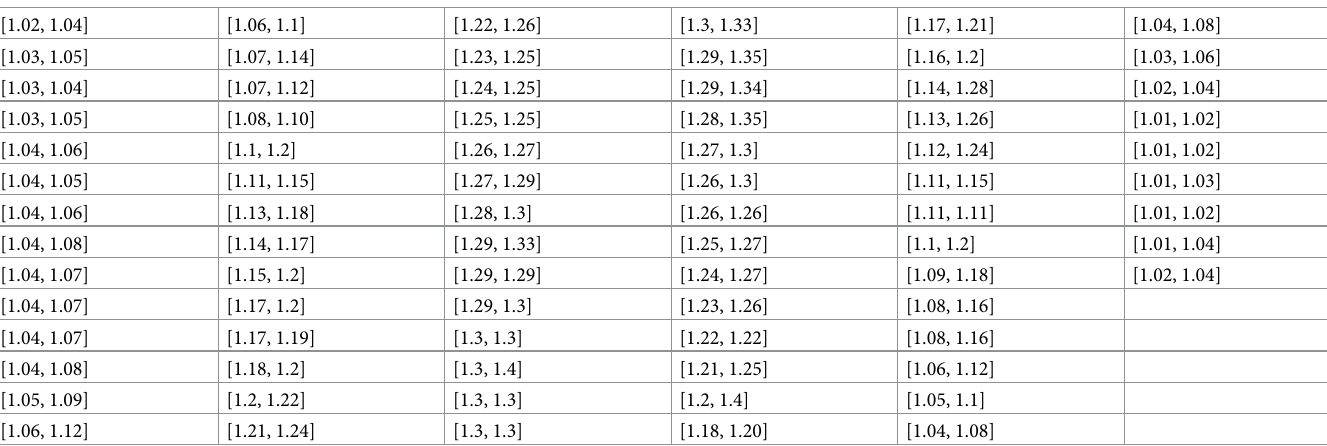
Table 1. Reproduction rate of coronavirus in